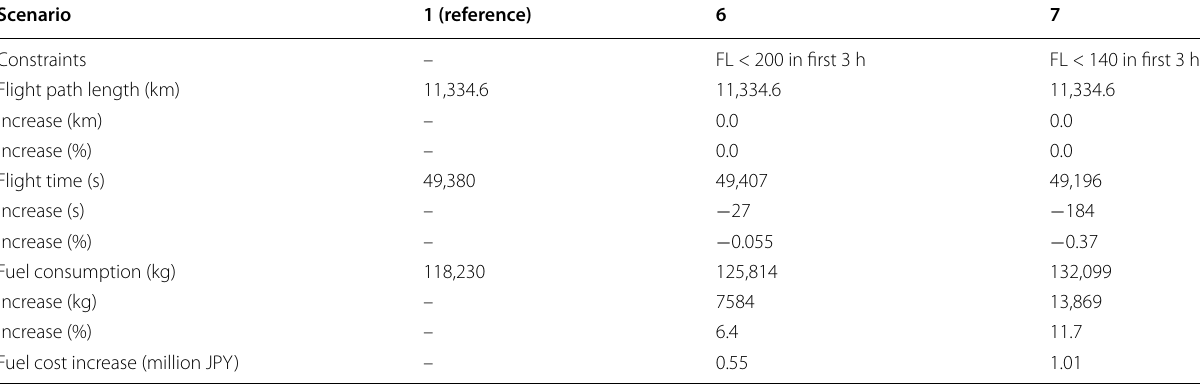
Table 3 Differences in the flight path length, flight time, and fuel consumption for JFK-NRT for ADR lasting in the first 3 h